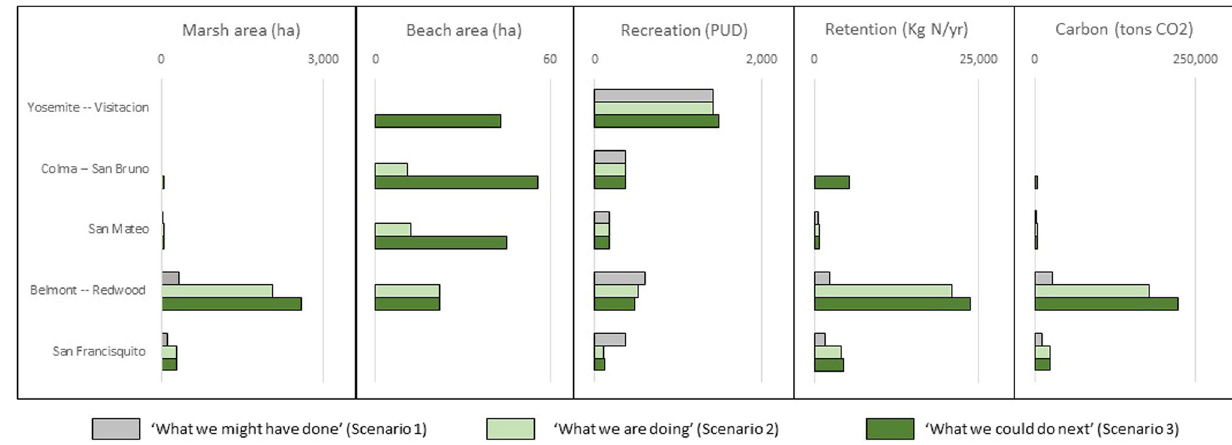
Fig. 6 Habitat and ecosystem services across San Mateo County ’ s fi ve Operational Landscape Units (OLUs) compared across the three adaptation scenarios. The scenarios compare: (1) ‘ What we might have done, ’ (2) ‘ What we are doing, ’ and (3) ‘ What we could do next. ’ Recreation is measured in ‘ PUD ’ or photo-user days, a proxy for the number of visitors. Carbon sequestration is measured from 2018 – 2050 for existing marsh and from 2030 – 2050 for new marsh.